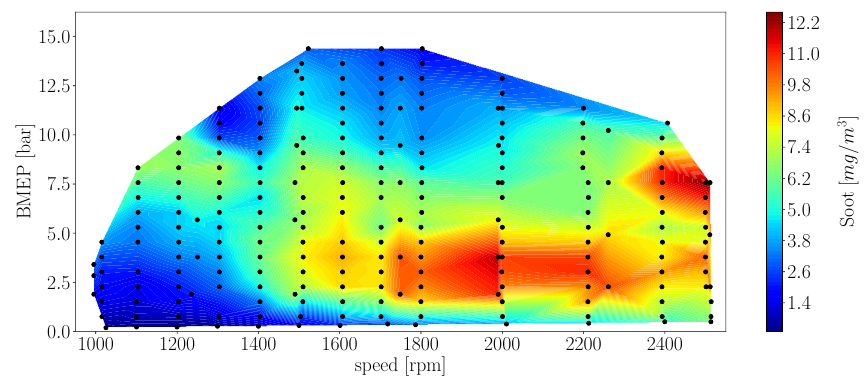
Figure 2. Engine-out soot measurements over speed and Break Mean Effective Pressure